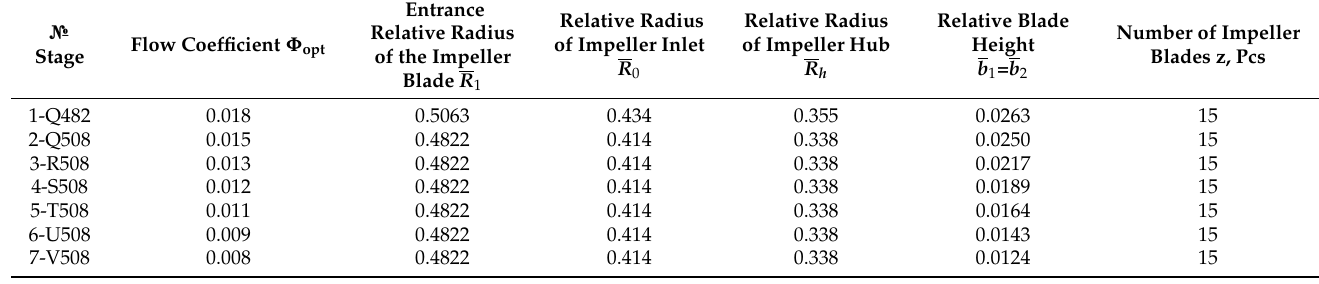
Table 2. Main used stages characterizations of model stages of base XX3B.